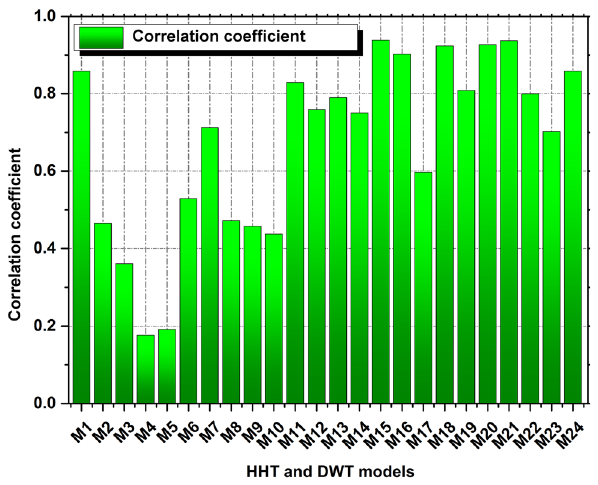
Fig. 5 Correlation coefficient between each pair series model result- ing from discrete wavelet transform and Hilbert Huang transform for the Oued Taria station